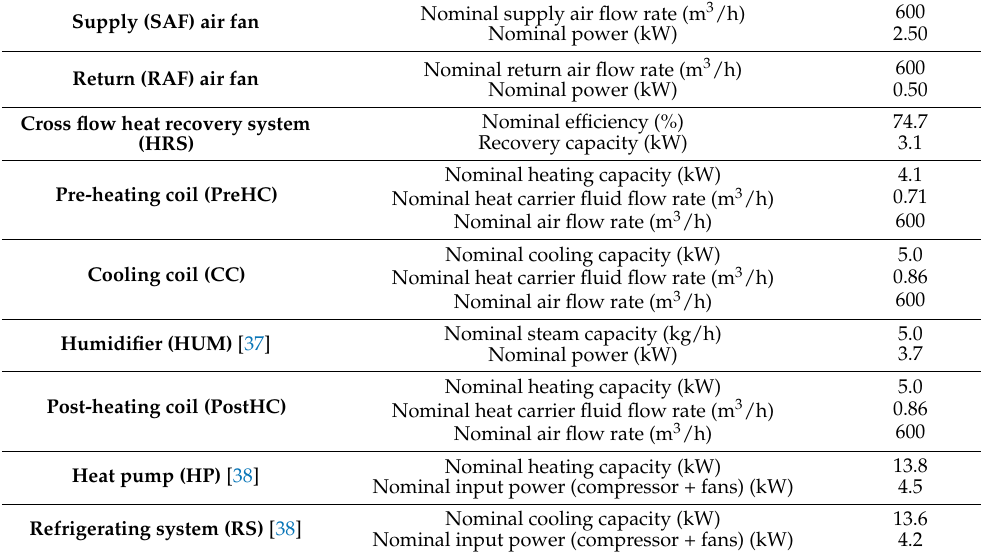
Table 1. Characteristics of the main AHU